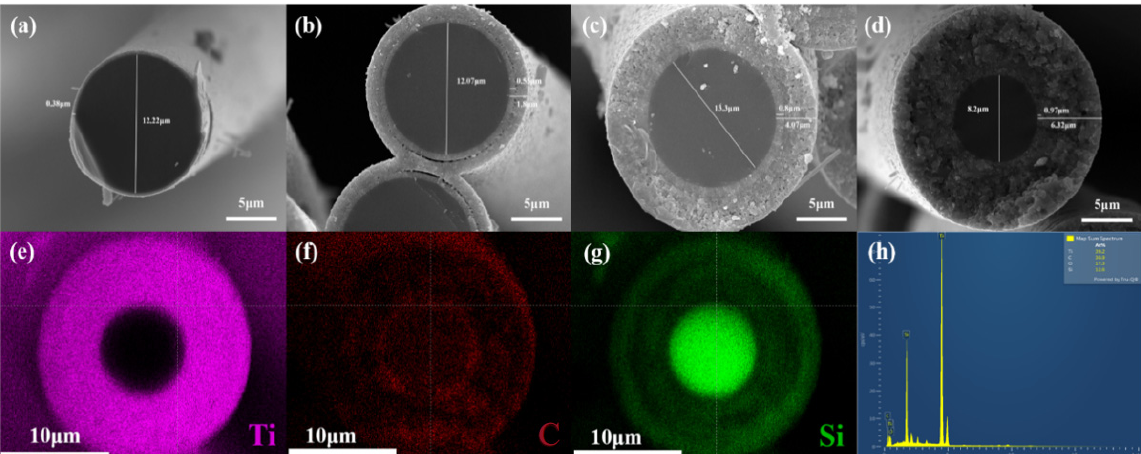
Figure 2. Cross-sectional morphologies of SiC fibers: ( a ) S900; ( b ) S1000; ( c ) S1100; ( d ) S1200; ( e – g ) EDX (Energy Dispersive X-Ray Spectroscopy) elemental mapping of S1200; ( h ) map sum spectrum of S1200.